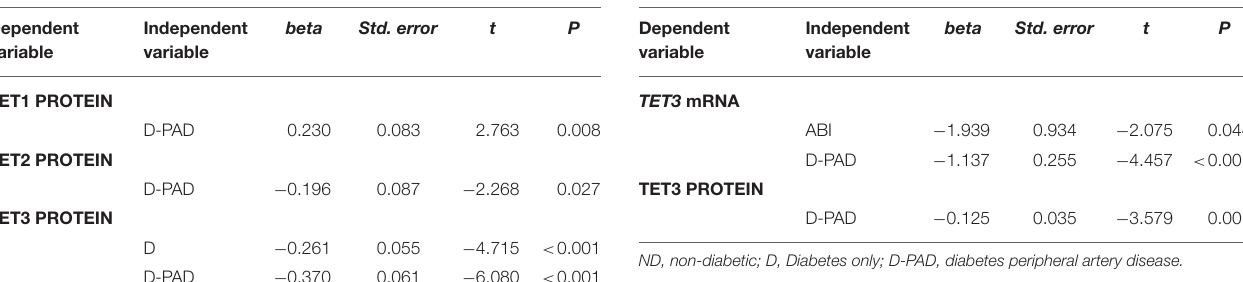
TABLE 5 | Multiple linear regression analysis to compare the TET3 mRNA and TET3 protein levels in D group with that in D-PAD